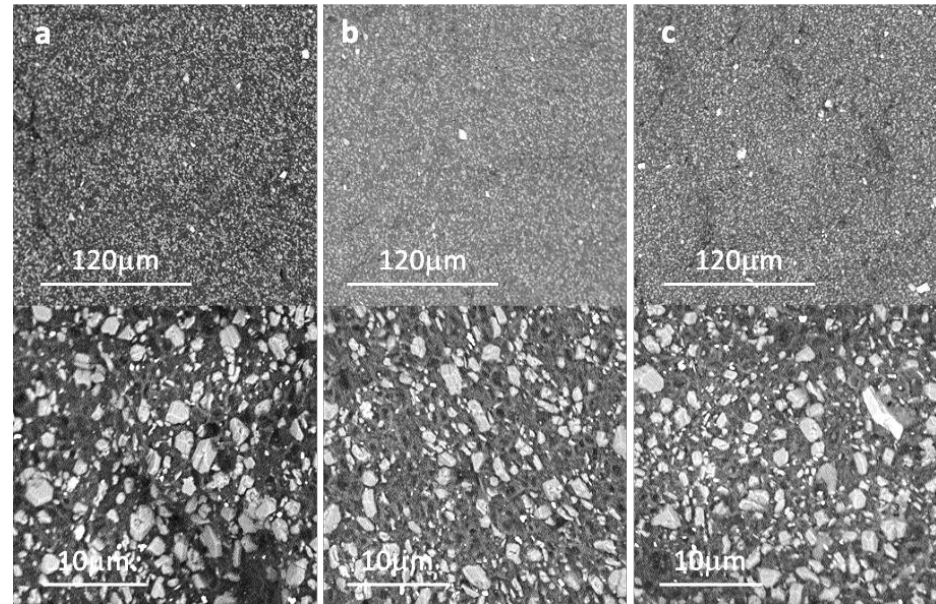
Figure 11. FE-SEM micrographs of EPDM compounds: ( a ) EPDM Reference, ( b ) EPDM OSep and ( c ) EPDM